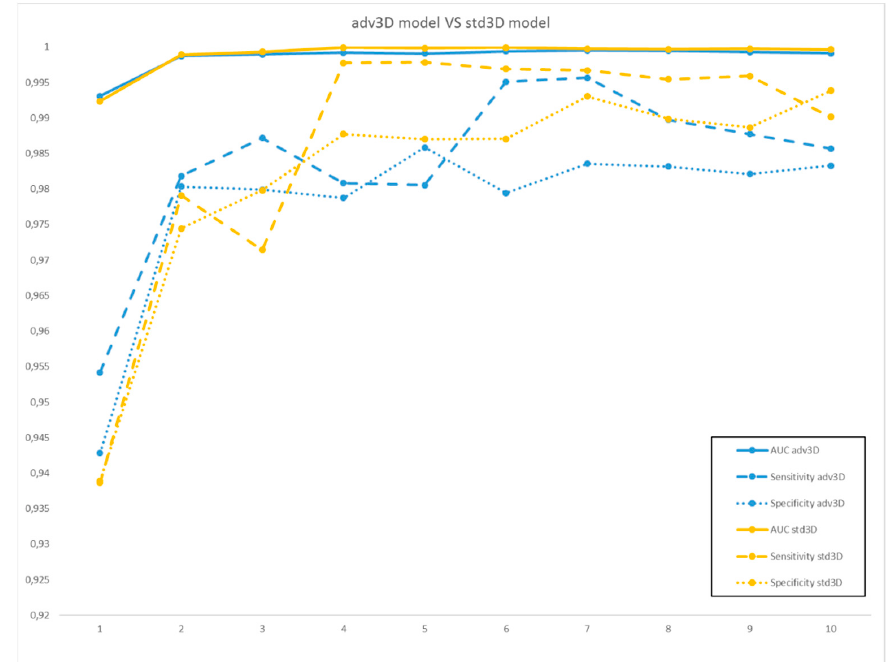
Figure 2. Area under the receiver operating characteristics curve (AUC) (full line), sensitivity (dashed line), and specificity (dotted line) of the multivariable models for adv3D (in blue) and std3D (in yellow), for model orders from 1 to 10.